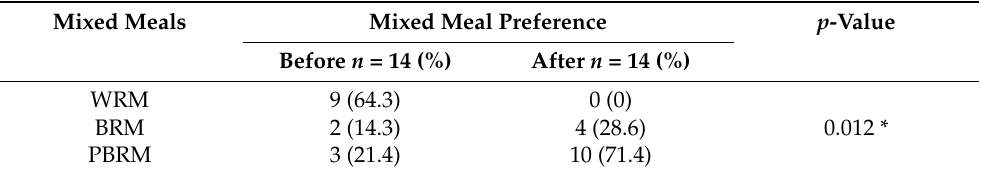
Table 5. Mixed meal preference before and after observing the trendline of the postprandial glucose levels indicated by